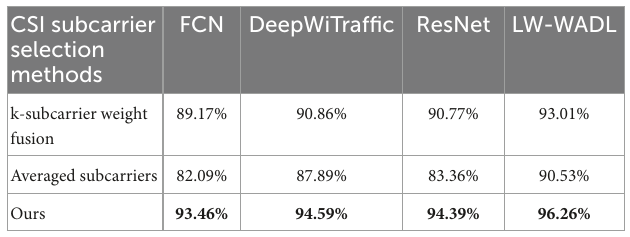
TABLE 3 Performance evaluation of different classification tasks. Tasks